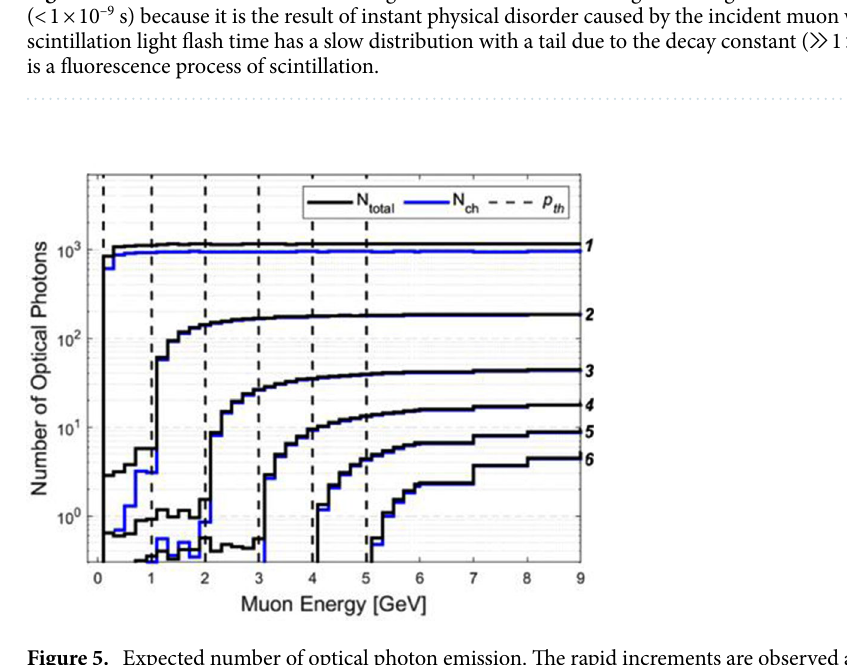
Figure 5. Expected number of optical photon emission. The rapid increments are observed at each threshold momentum level (vertical dashed lines) because of Cherenkov radiation emission above the threshold momentum levels. Then, it gradually increases as muon energy increases. The italicized numbers ( 1–6 ) on the right represent the radiator